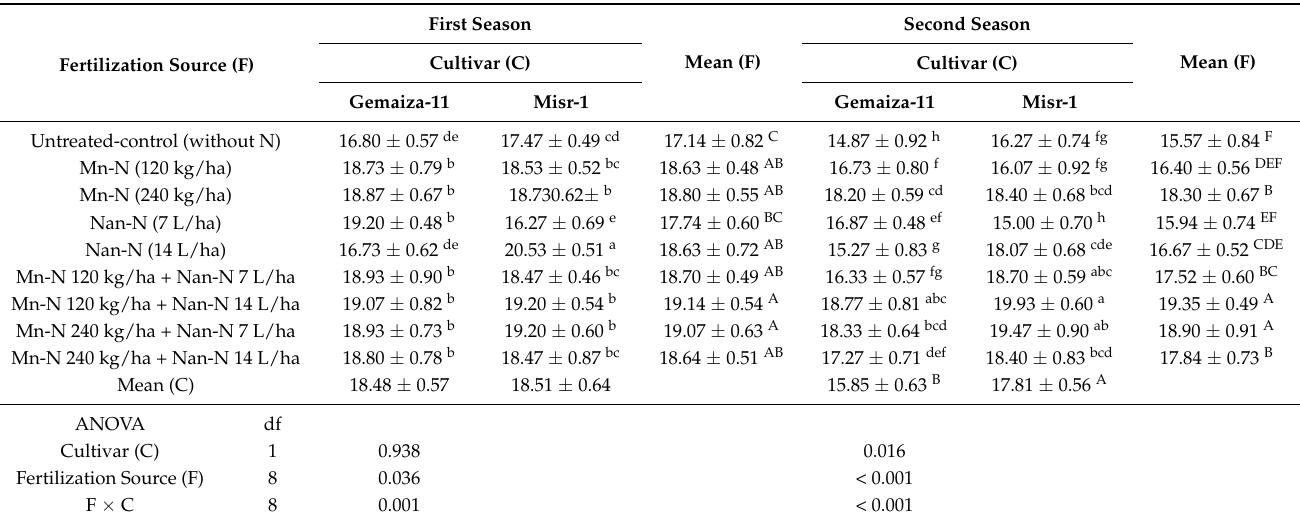
Table 5. Impact of nano- and mineral nitrogen fertilizers on number of spikelets/spike of wheat cultivars during the 2019/2020 and 2020/2021